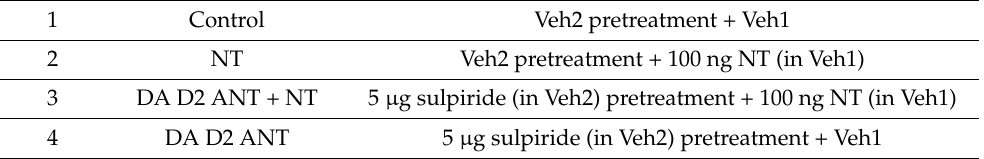
Table 1. Animal groups and